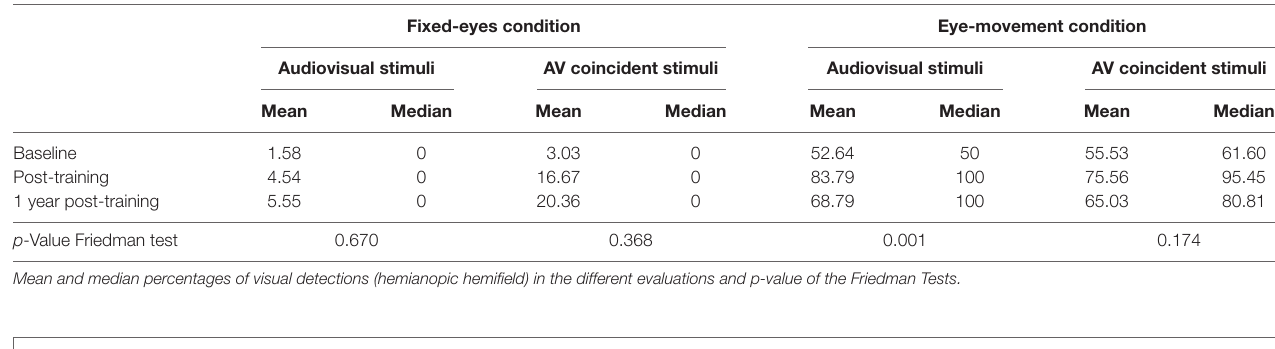
tABle 2 | Subject 2: bimodal audiovisual